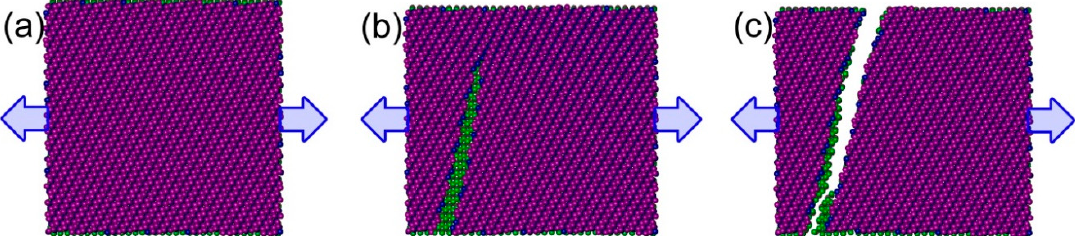
Figure 3. Top view of the atomic configurations of the angle-ply DLBP with δ = 60° at selected stages during tensile process in the X-axis: ( a ) ε = 0; ( b ) ε = 0.096; and ( c ) ε = 0.117. The stacking angles θ T = 60° and θ B = 0°.